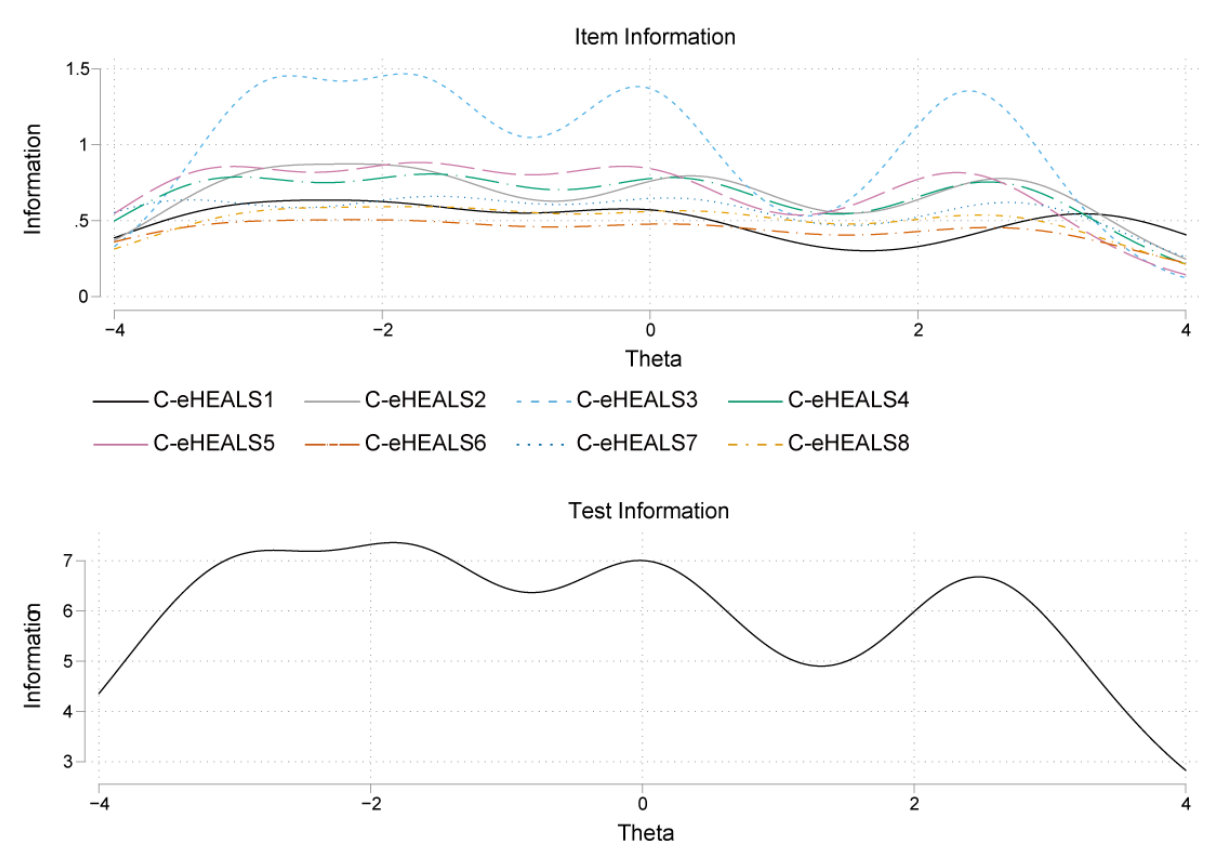
Figure 3. Item information curves and test information function for item characteristic curves. Curves indicate the amount of psychometric information (ie, the reciprocal of the standard error of measurement) provided by the instrument. C-eHEALS: Chinese version of the eHealth Literacy Scale.